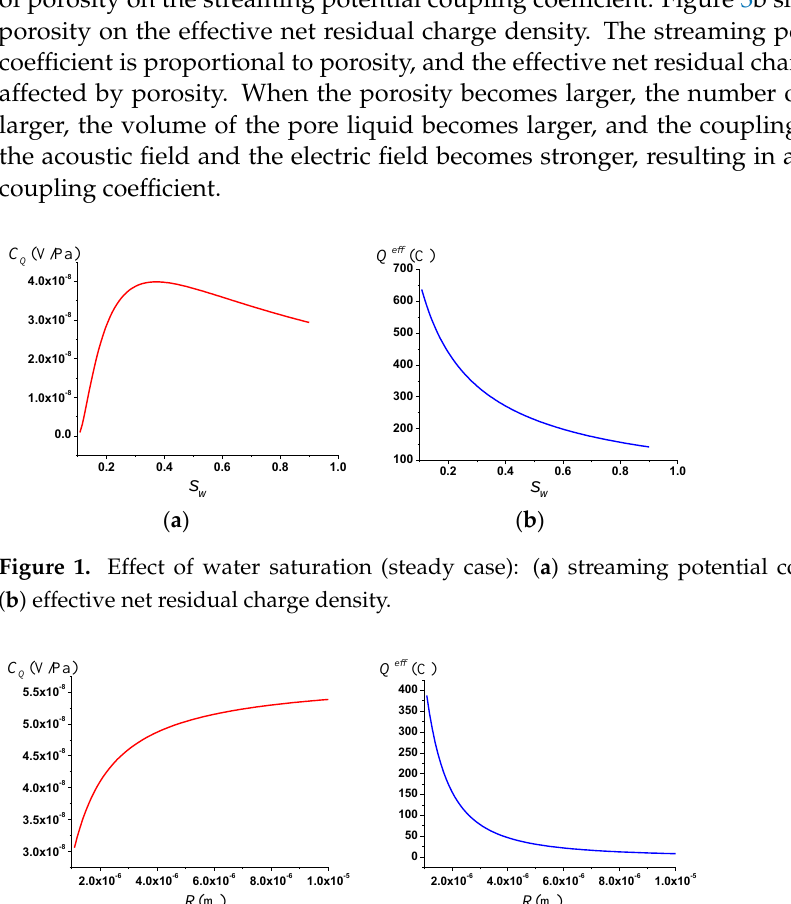
Figure 2. Effect of pore size (steady case): ( a ) streaming potential coupling coefficient; ( b ) effective net residual charge density. net residual charge density.